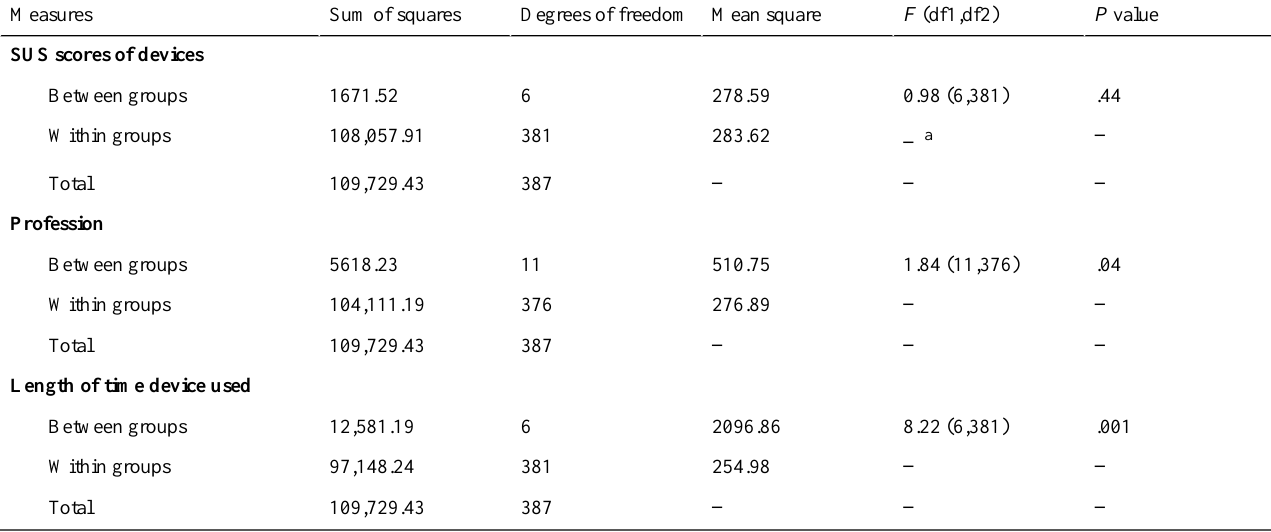
Table 7. ANOVA tests of the System Usability Scale (SUS) scores of the seven devices and of the volunteer’s demographic information (profession, length of time the device was